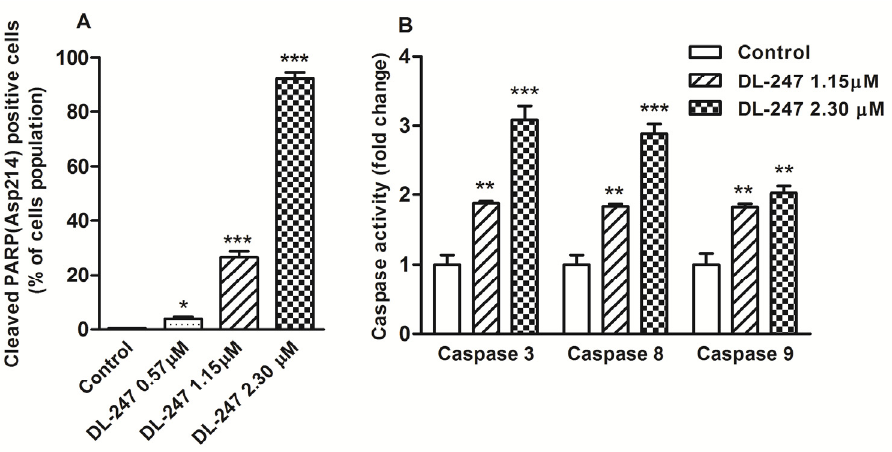
Figure 4. Induction of caspase activity in HL-60 cells treated with DL-247 for 24 h. (A) Percentage of cleaved PARP positive cells measured by flow cytometry (PE Mouse Anti-Cleaved PARP (Asp214) antibody staining). (B) Effect of DL-247 on caspase-3, -8 and -9 activity measured by fluorometric